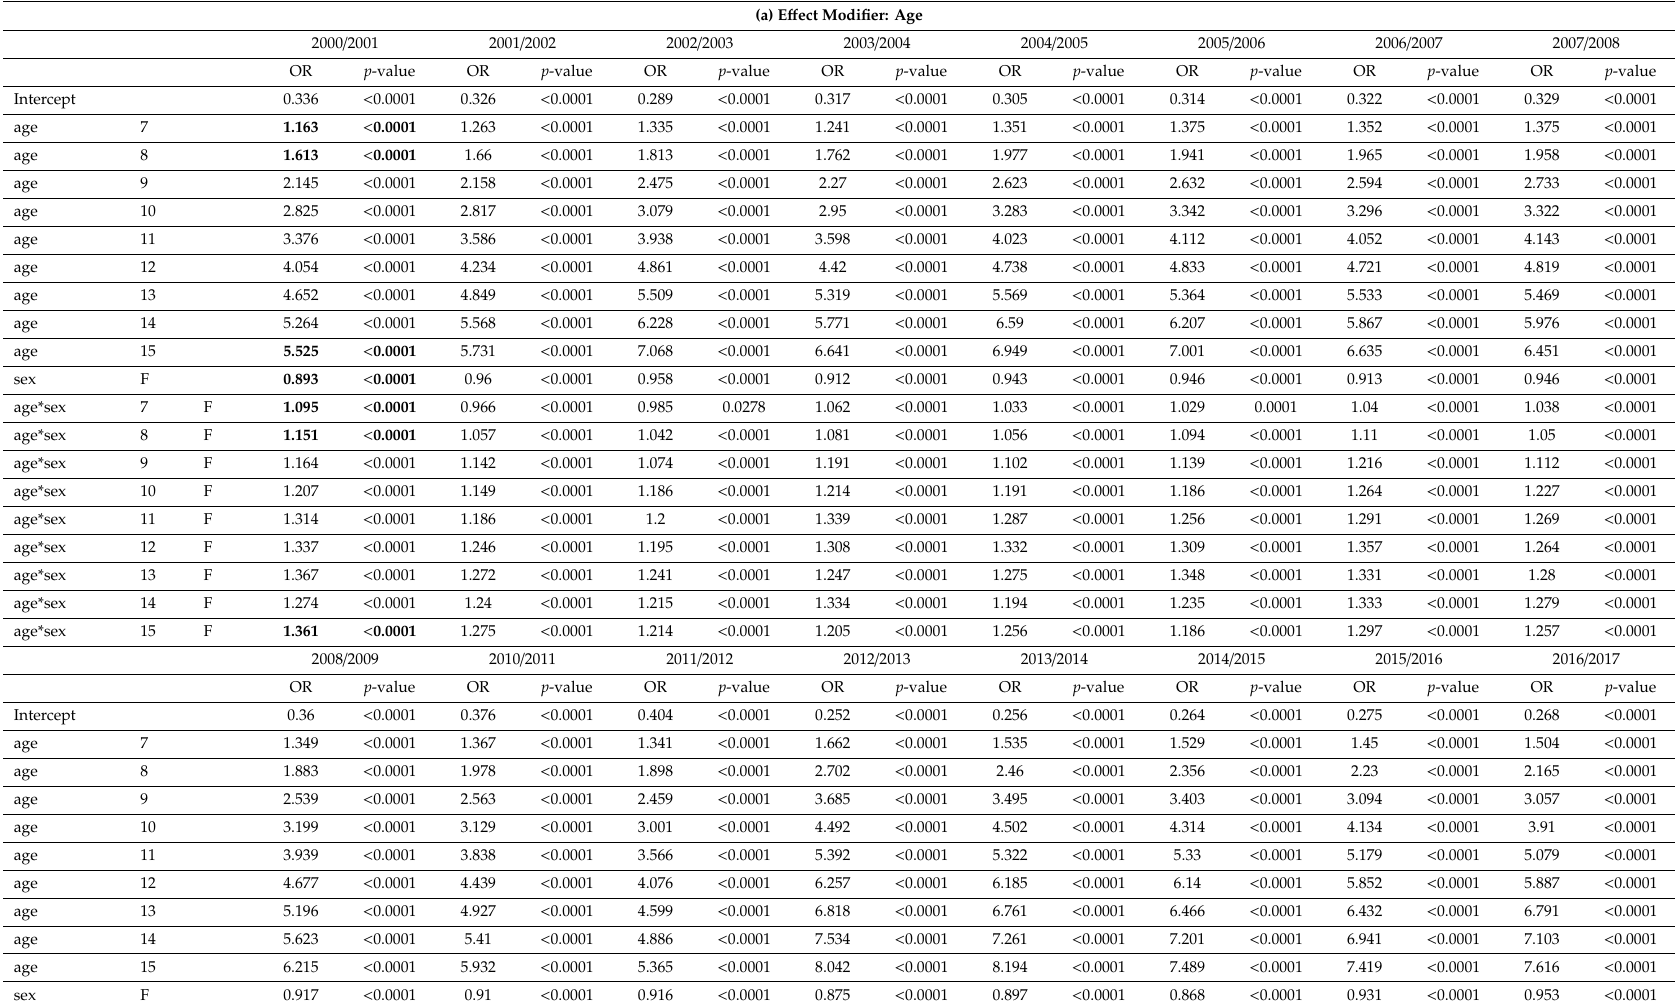
Table 2. Interaction e ff ect of age (or grade) on the association between sex and reduced visual acuity. (a) E ff ect Modifier: